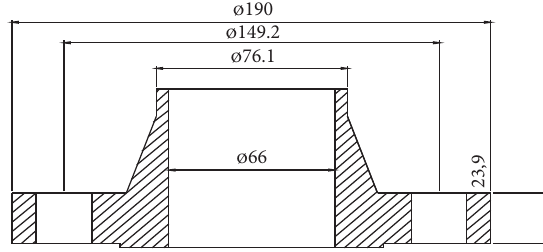
Figure 16: Geometry of the butt welding flange joint.